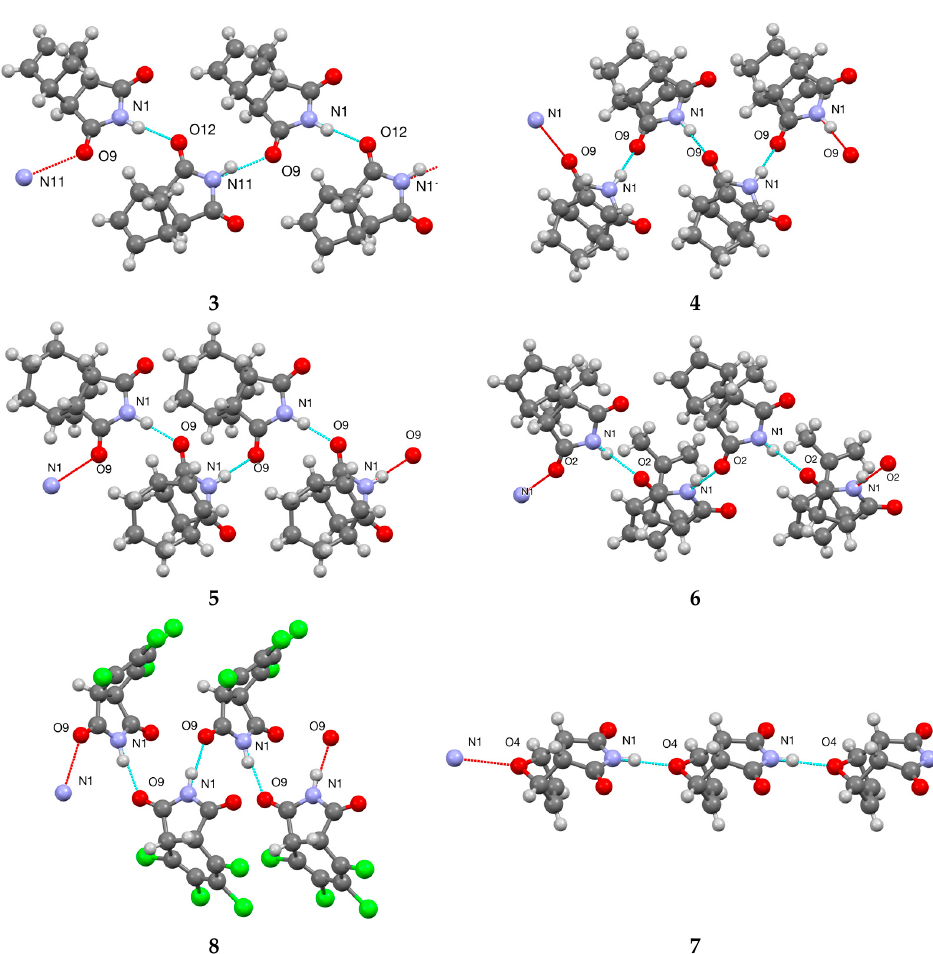
Figure 7. Hydrogen bonded C (4) structures for 3 , 4 , 5 , 6 and 8 and C (6) structure for 7 .